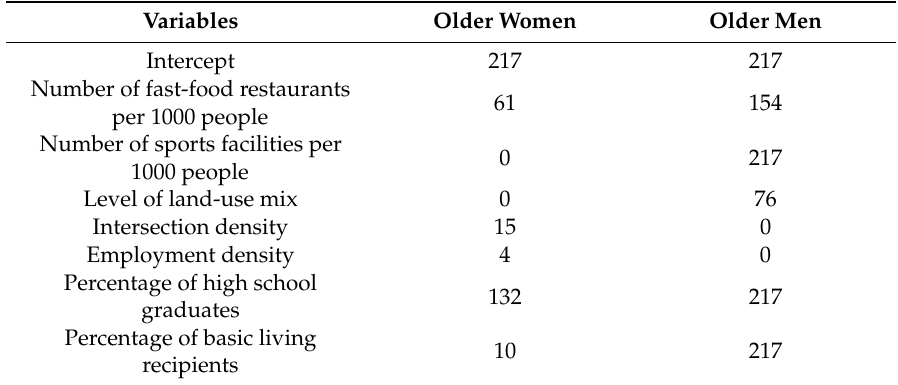
Table 4. The number of localities with significant coe ffi cients in GWR for older men and women. Variables Older Women Older Men Intercept 217 217 Number of fast-food restaurants 61 154 per 1000 people Number of sports facilities per 0 1000 people Level of land-use